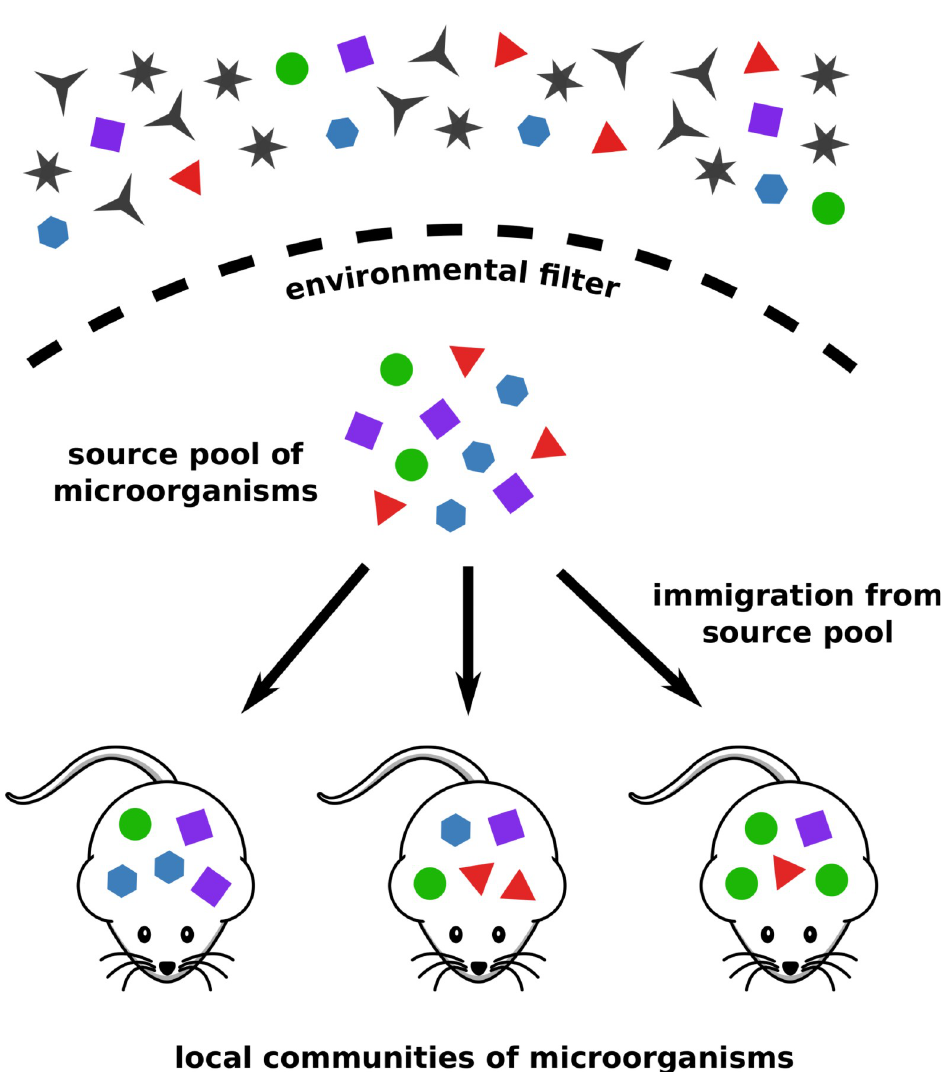
Fig 1. Sketch of the setup of the neutral model. Only a subset of the available microorganisms can pass through the environmental filter, forming a common source pool for all hosts. This selective step is not described by the neutral model. The microbiota of individual hosts form local communities, and the microbial intra-host population dynamics are neutral. Local diversity is maintained by immigration from the source pool.